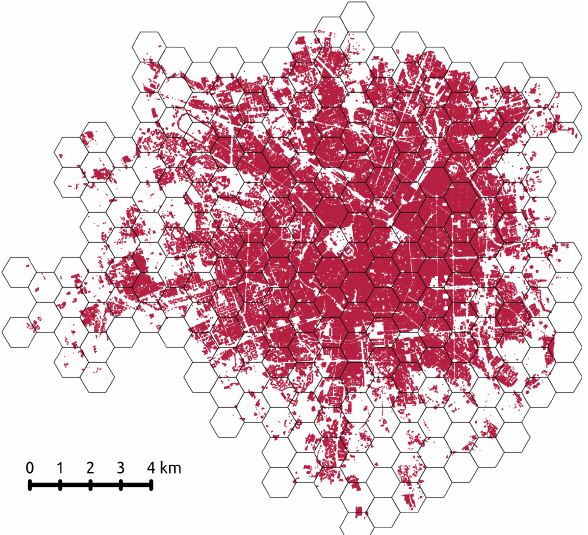
Figure 5. Hexagonal grid and reference building roofs for